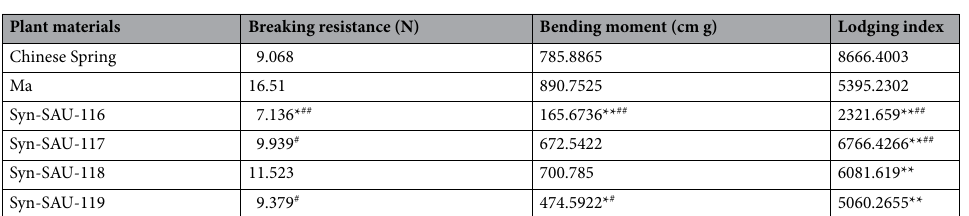
Table 3. Investigation of lodging resistance of synthetic hexalpoid wheat in the field. *Significantly different from CS at the 0.05 level, **at the 0.01 level; # significantly different from T. durum Ma at the 0.05 level, ## at the 0.01